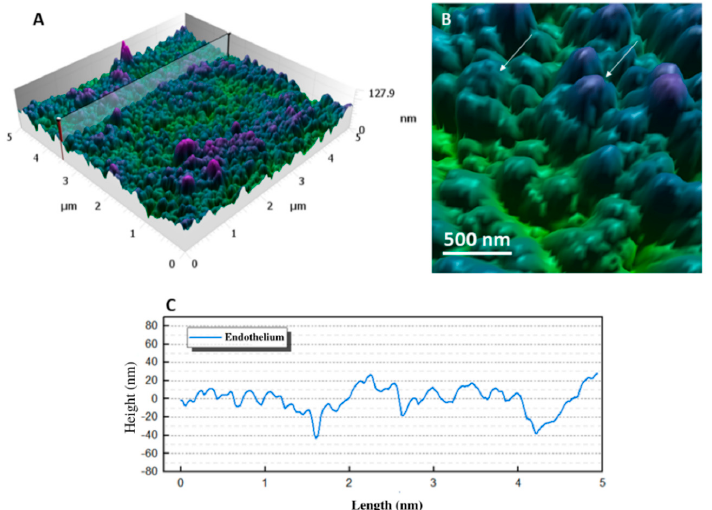
Figure 7. The surface of the endothelial layer. ( A ) Three-dimensional visualization of the 5 × 5 µm human corneal endothelial cell surface topographic map. ( B ) Enlarged image of this region showing the morphology of the ultrastructural structures. White arrows indicate globular structures compatible with macromolecules embedded in the membrane. ( C ) The heightmap cross-sections corresponding to the region marked in image ( A ).